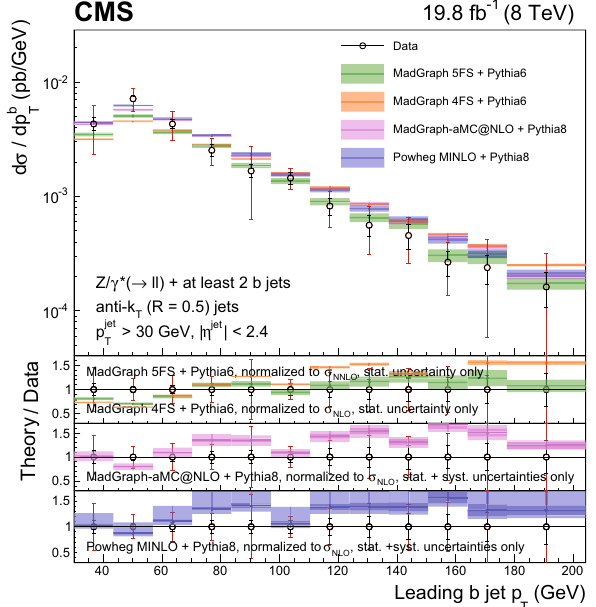
Fig. 10 Differential fiducial cross section for Z(2b) production as a functionofthesubleadingbjet p T ,comparedwiththe MadGraph 5FS, MadGraph 4FS, MadGraph5 _a MC@NLO , and powheg minlo the- oretical predictions ( shaded bands ), normalized to the theoretical cross sections described in the text. For each data point the statistical and the total (sum in quadrature of statistical and systematic) uncertainties are represented by the double error bar . The width of the shaded bands represents the uncertainty in the theoretical predictions, and, for NLO calculations, theoretical systematic uncertainties are added in the ratio plots with the inner darker area representing the statistical component